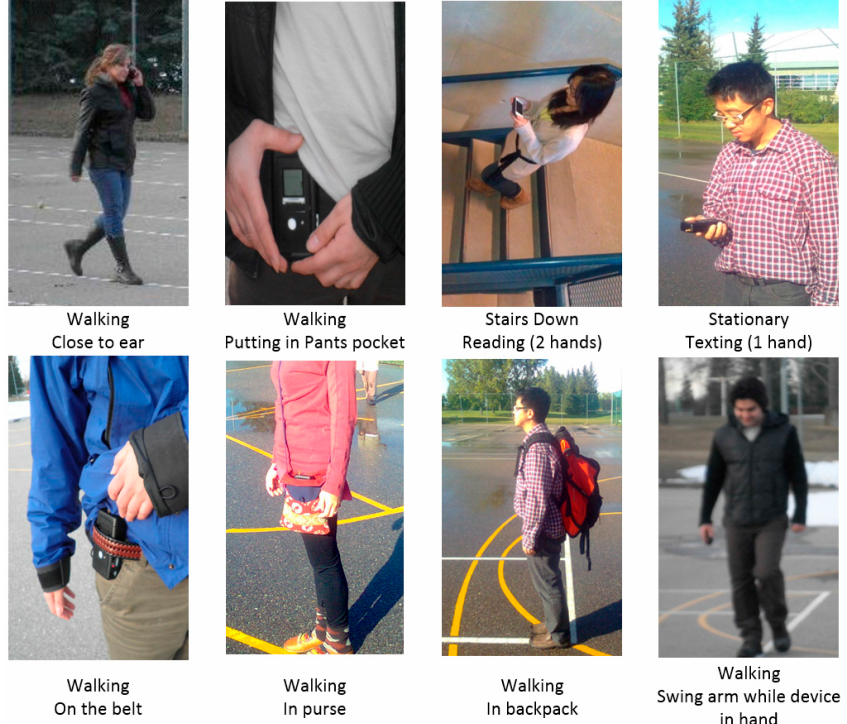
Figure 3. Schematic diagram of the data collection process.